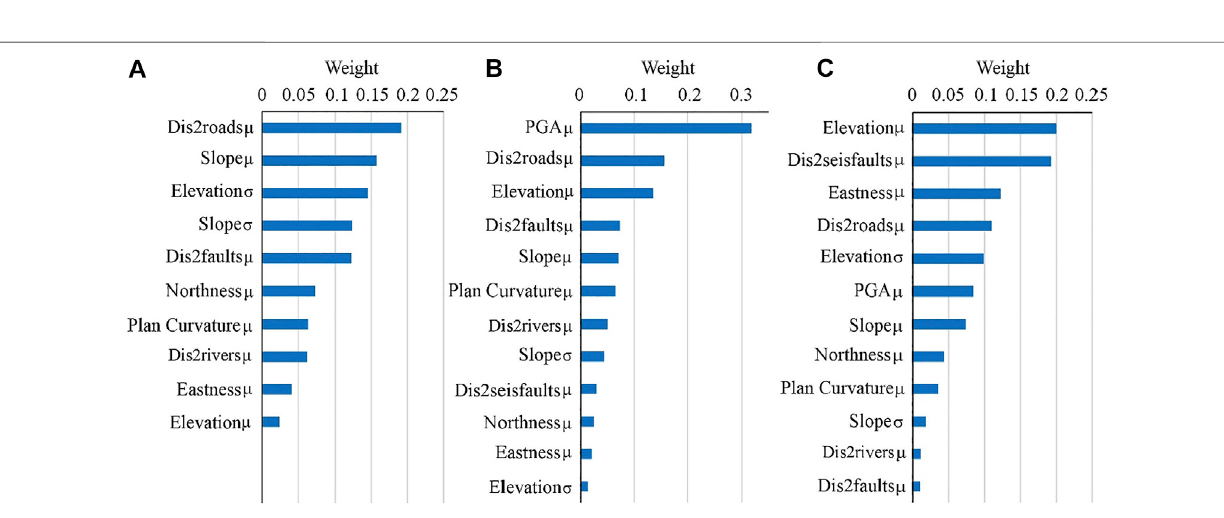
Frontiers in Environmental Science |